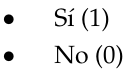
Communalities table from the second Exploratory Factor Analysis using Principal Axis Factoring and Varimax rotation for the 27 items retained from the Social Distance Item Pool (described in Step 2 of